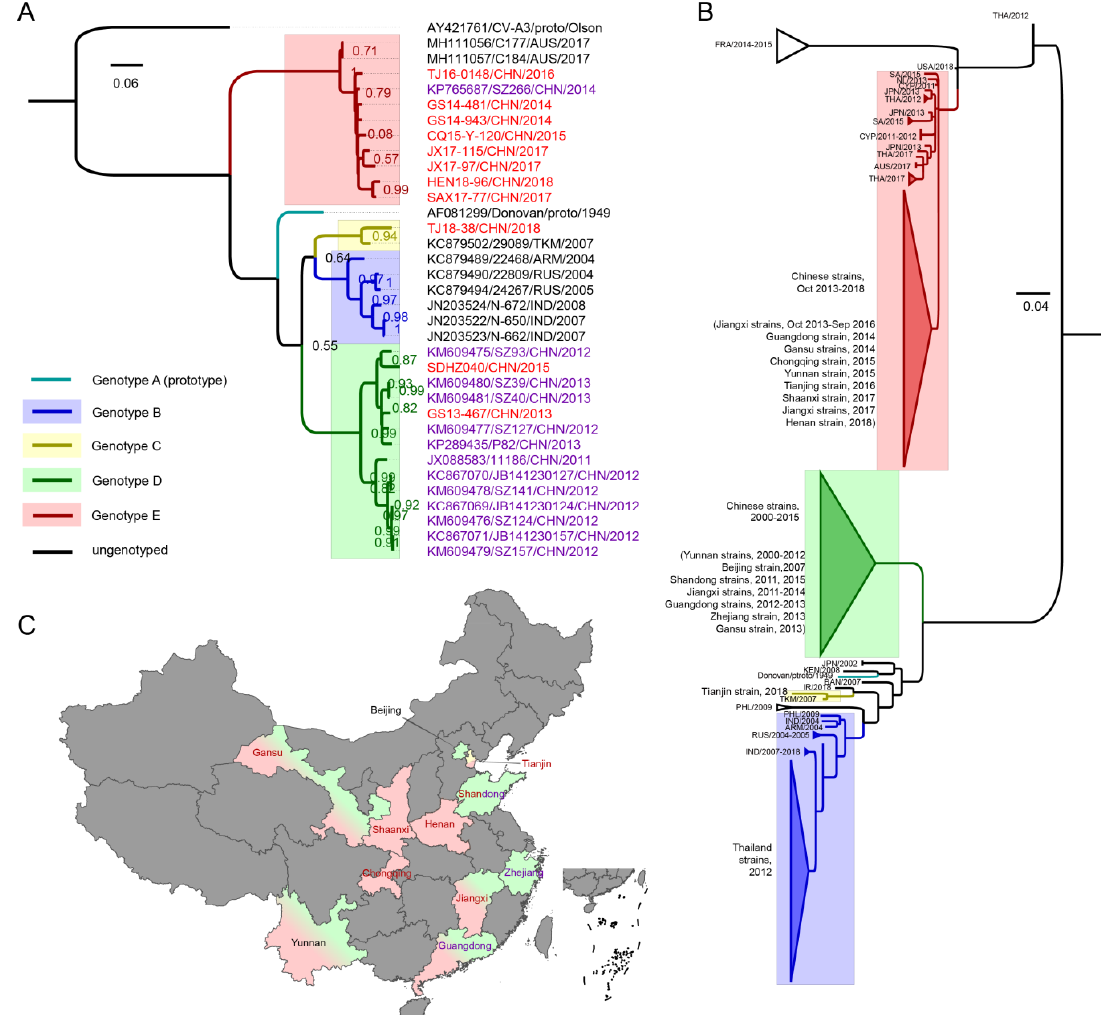
Figure 1. ( A ) Genotyping result of the maximum likelihood phylogenetic tree of CV-A8 strains constructed based on 34 complete VP1 sequences; the coxsackievirus A3 (CV-A3) prototype strain (AY421761) was used as an outgroup, support was estimated with 1000 bootstrap replicates and the bootstrap cut-off threshold was set to 0.50. The genotypes are differentiated by distinct colours, which are indicated on the left, and the names of the sequences are noted on the right. The Chinese isolates from this study are marked in red, and the Chinese isolates from GenBank are marked in purple. ( B ) Unrooted maximum likelihood phylogenetic tree of 171 global CV-A8 partial VP1 sequences. Information on the strains detected within each genotype is indicated on the left of the tree. ( C ) The geographical distribution of CV-A8 genotypes in China. The provinces are indicated by the colour(s) of the circulating genotype(s), the name of each province is located on the map, the provinces that provided the complete VP1 sequence(s) from this study are marked in red and those from GenBank in purple, and the geographic map of China was taken from Highcharts (grant number: 0321912045738052).